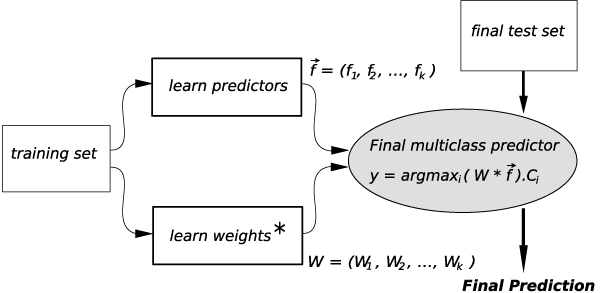
The mechanism for learning code weights. The figure shows the cross-validation set-up for supervised learning of the weight vector W.